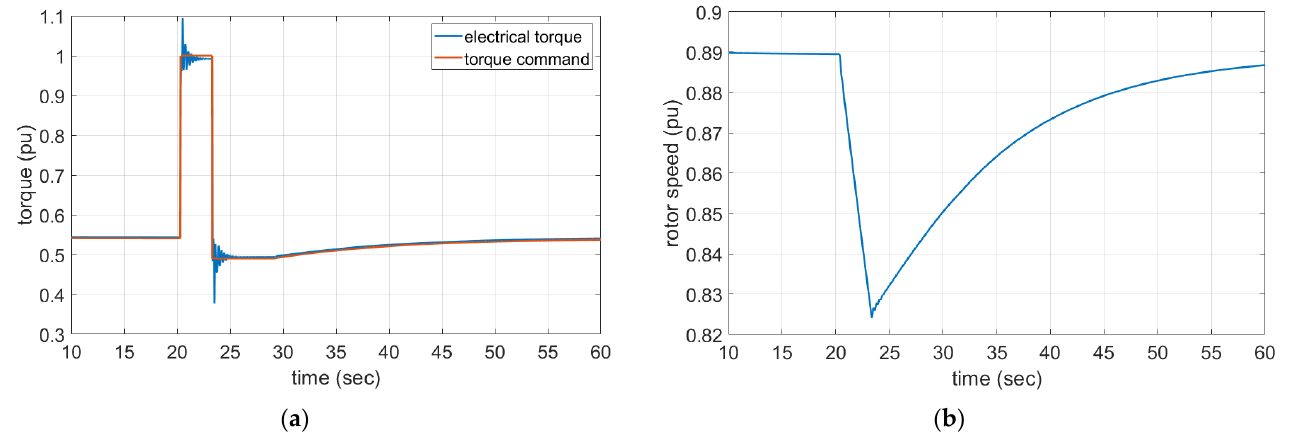
synchronous generator #1; ( d ) output power of the BESS.